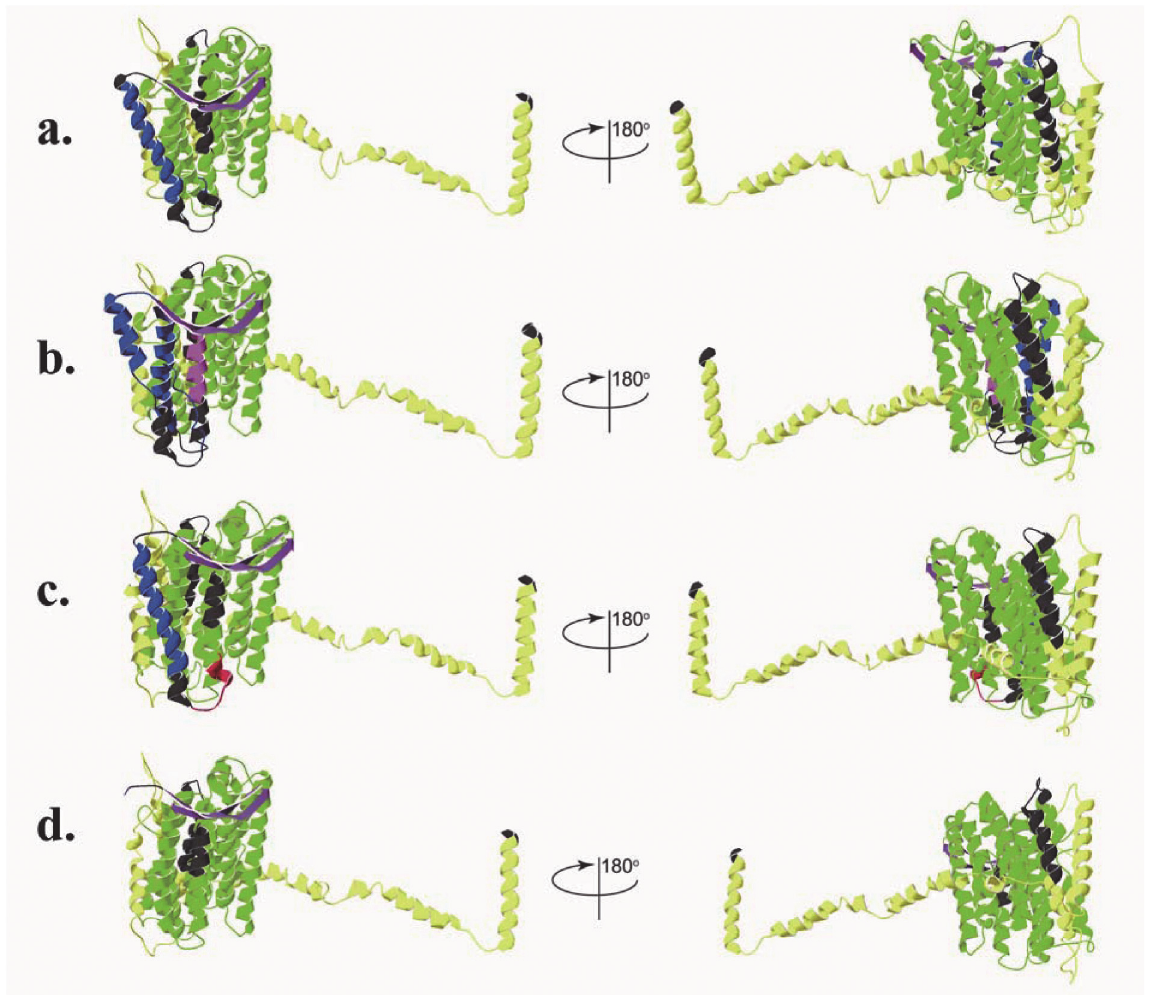
Fig 7. The predicted three-dimensional structures of ND5 proteins. a: Ribbon diagram structure of ND5-1 from H . rugulosus (BT). b: Ribbon diagram structure of ND5-2 from H . rugulosus (BT). c: Ribbon diagram structure of ND5 from H . rugulosus (WT). d: Ribbon diagram structure of ND5 from H . tigerinus . The signal peptide is shown in red, transmembrane regions in blue and β strands in purple. The Oxidored_q1_N and Oxidored_q1 regiona are shown in green. The NADH5_C region is shown in yellow. α helices and loops outside of the domain regions are shown in black. The low complexity region is marked in pink. Signal peptide and transmembrane regions of ND5 from H . tigerinus aer not shown in part